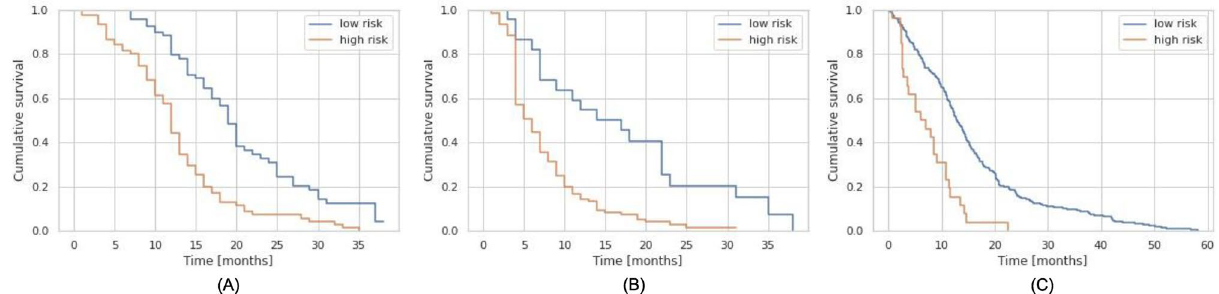
Figure 6. Kaplan–Meier curves showing the cumulative survival (fraction of the population alive/without progression at a given time), for ( A ) OS and ( B ) PFS in the Copenhagen dataset and ( C ) for OS in the BraTS20 dataset. The two survival groups in each figure are obtained by splitting the cohort based on the predicted survival at the threshold that best separates the cohort.